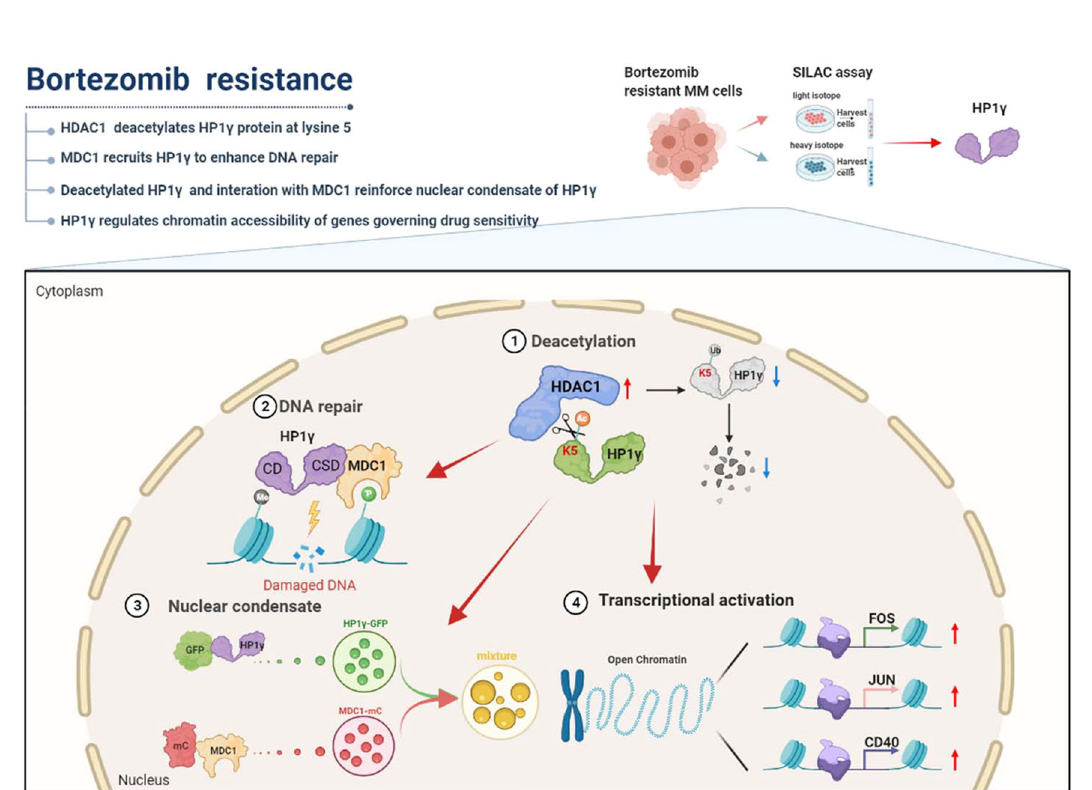
Fig. 9 | Proposed schematic diagram for mechanisms of HP1 γ -MDC1-HDAC1 regulating axis in MM drug resistance. HP1 γ -MDC1 complex recognizes the DSB sites and exerts the function of DNArepair, as well as how the nuclearcondensation